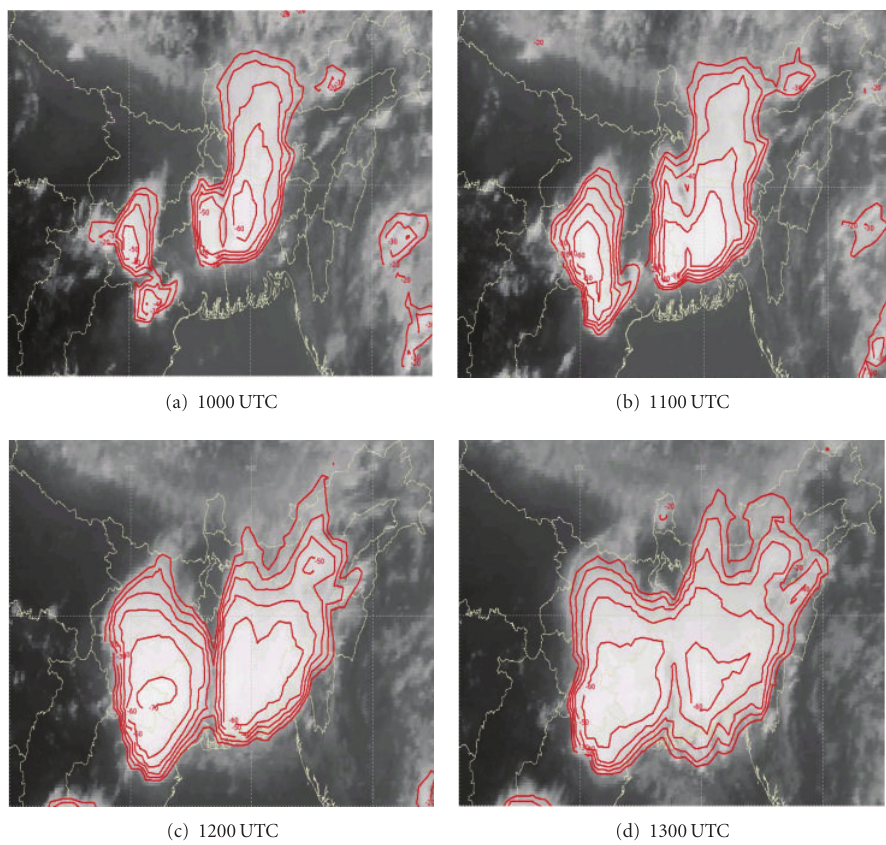
Figure 13: Kalpana satellite derived cloud top temperature ( ◦ C) imageries from 1000 to 1300 UTC on 03, May,